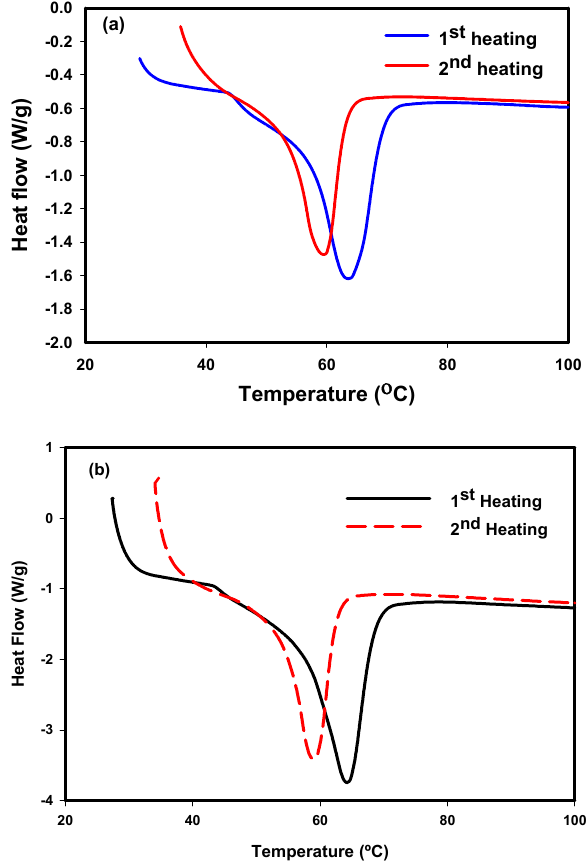
Figure 14. Melting endotherms at the first and second heating scans of PCL fibers prepared by Forcespinning ® of 12.5 wt% PCL solutions in in DMF:THF ( a ) (0:100) and ( b ) (30:70) mixtures at a rotational speed of 5000 rpm. The secondary crystallization process disappeared after the second DSC heating scan for both samples.